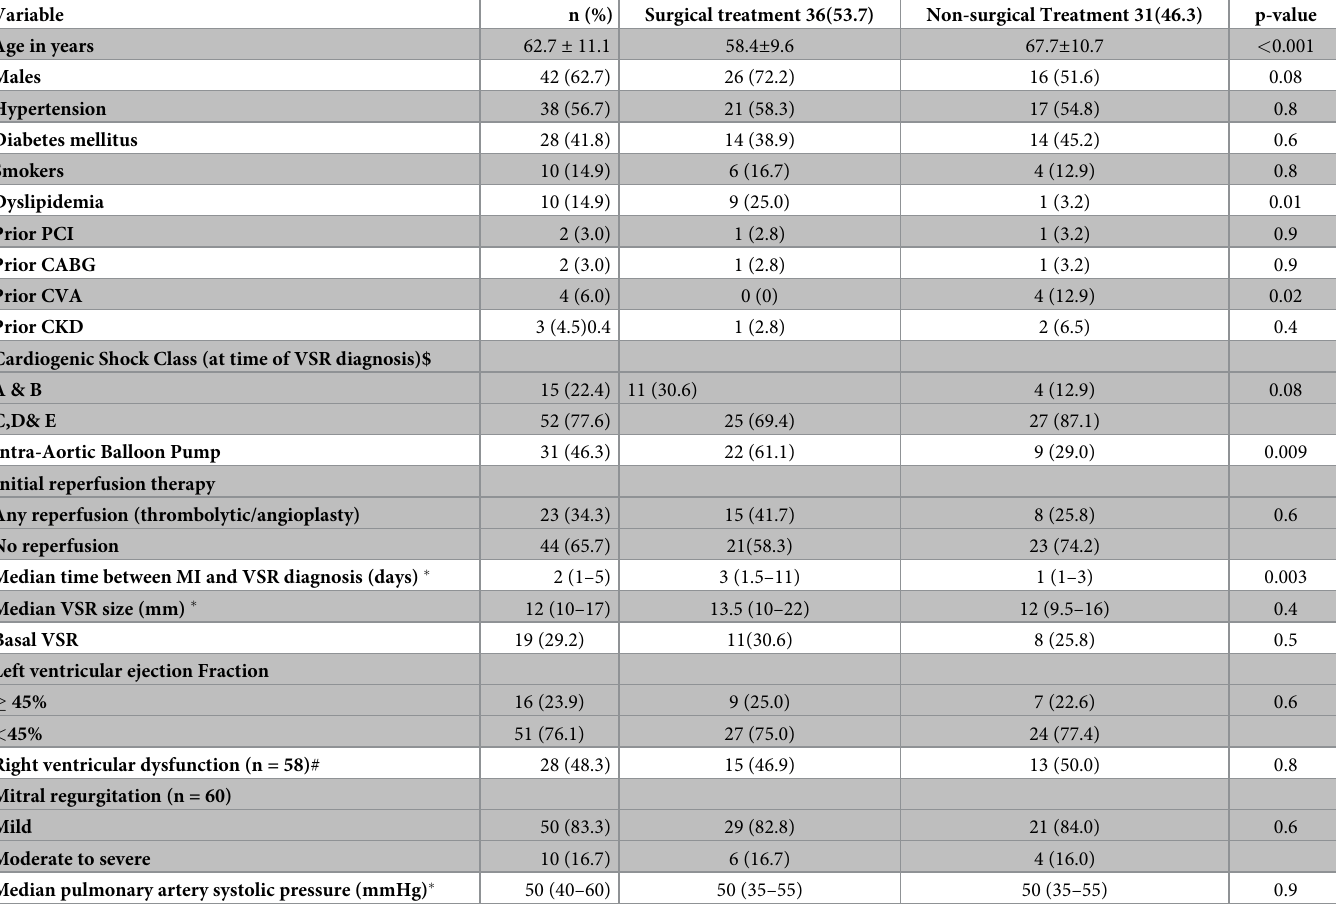
Table 1. Characteristics of subjects with ventricular septal rupture as per surgical and non-surgical intervention (N =